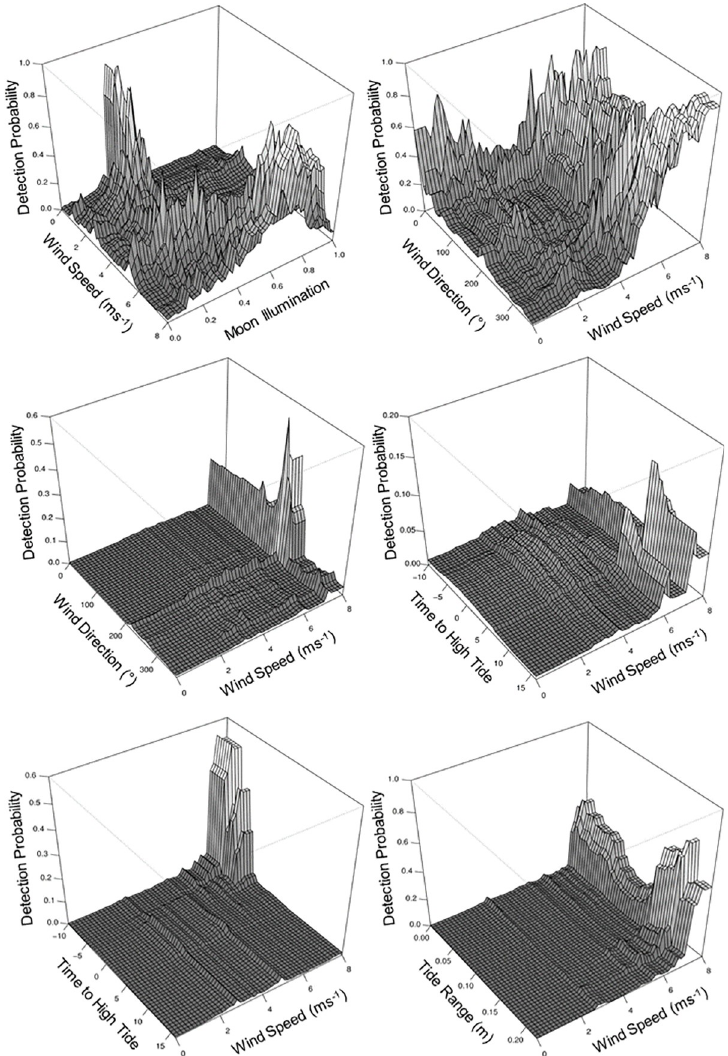
Fig 5. Interactions between predictor variables for all three locations. Pairwise interactions between predictor variables while keeping all other variables at their respective mean showing the probability of M . alfredi tag detections at Hanifaru Bay (top row), Dhigu Thila (middle row), and Nelivaru Thila (bottom row). All interactions were significant ( p < 0.01). Note z-axis scale varies depending on the influence of the interaction.